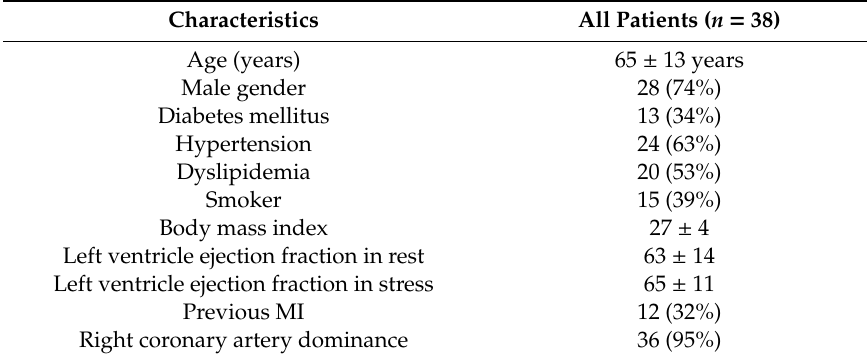
Table 1. Baseline characteristics of patients.